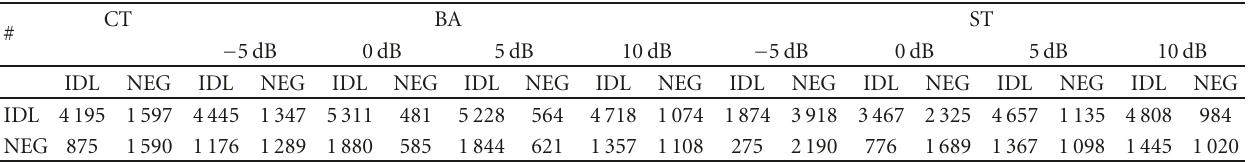
Figure 3: Optimization of the SMO kernel complexity parameter C on the mean unweighted average recall (UAR) on the development set of the FAU Aibo Emotion Corpus across the CT, BA, and ST test conditions, including all available SNRs from − 5 to 10dB. For the experiments on the test set (Table 5), the value of C that achieved the best performance on average over all test conditions (CT, BA, and ST) was selected (depicted by larger symbols). The graphs for the N30 and IS+ N30 sets are not shown for the sake of clarity, as their shape is roughly similar to N31 and IS + N31. Table 6: Confusion matrices on the Aibo 2-class problem with additive noise (8257 test instances) for clean training, using the IS feature set and an SVM classifier with complexity parameter C = 0 . 2, as in Table 5(a). The following test conditions were considered: CT (clean), BA (babble noise at − 5–10 dB SNR), and ST (street noise at − 5–10 dB